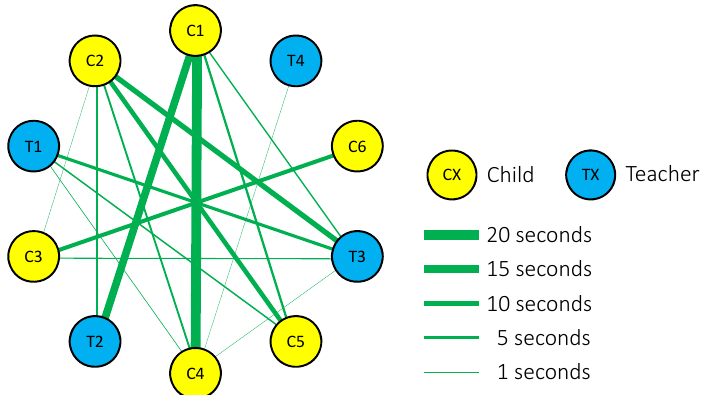
Figure 10. Correlation diagram made from the data obtained from the devices: the yellow and blue circles show the children and teachers, respectively; the thickness of the green line represents the duration of face-to-face